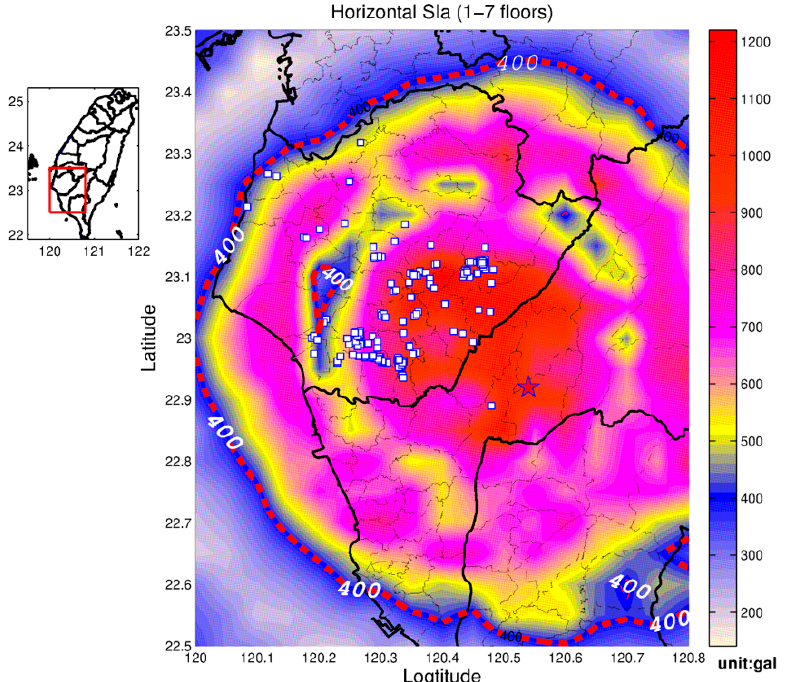
Figure 8. SIa distribution calculated using the inverted source model. The dashed line indicates areas with an SIa value of 400 gal; damaged buildings with 1–6 floors were located within the contour line. The red star represents the hypocenter of the Meinong earthquake, and the white squares represent the buildings damaged by this earthquake [36].